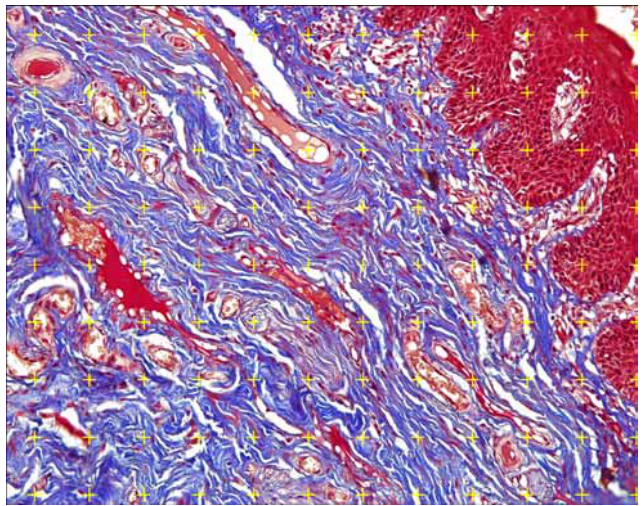
Figure 1 - Photomicrography showing the morphometric analysis of the foreskin. Quantification of vascular density of the foreskin in a 23 years old smoker using the image J Test Grid software. Masson’s trichrome